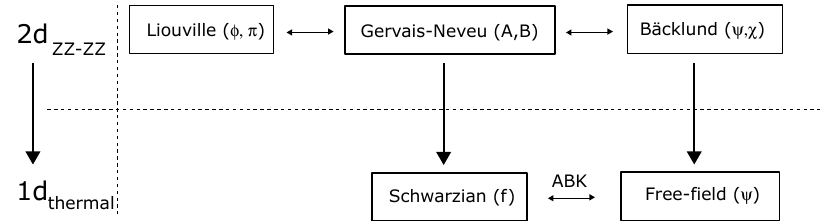
Figure 5 . Liouville theory in 2d in its di(cid:11)erent incarnations, and the resulting 1d theory one (cid:12)nds upon taking the double scaling (classical) limit. The rede(cid:12)nition _ f = e utilized by Altland, Bagrets and Kamenev (ABK) [37, 38], is the dimensional reduction of the transition from Gerveu-Neveu variables to B(cid:127)acklund